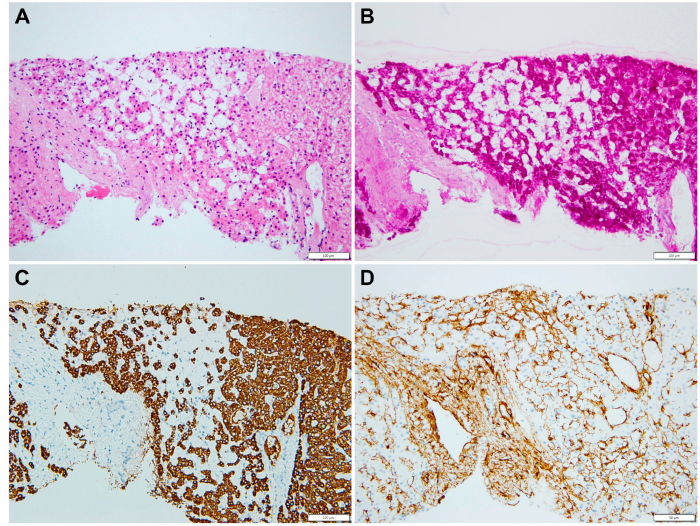
Figure 3. ( A ) Empty cells are mixed with small (atrophic) hepatocytes (HE, 20 × ). ( B ) Empty cells have no glycogen in the cytoplasm (PAS, 20 × ); ( C ) Empty cells are not abnormal hepatocytes (HepPar1